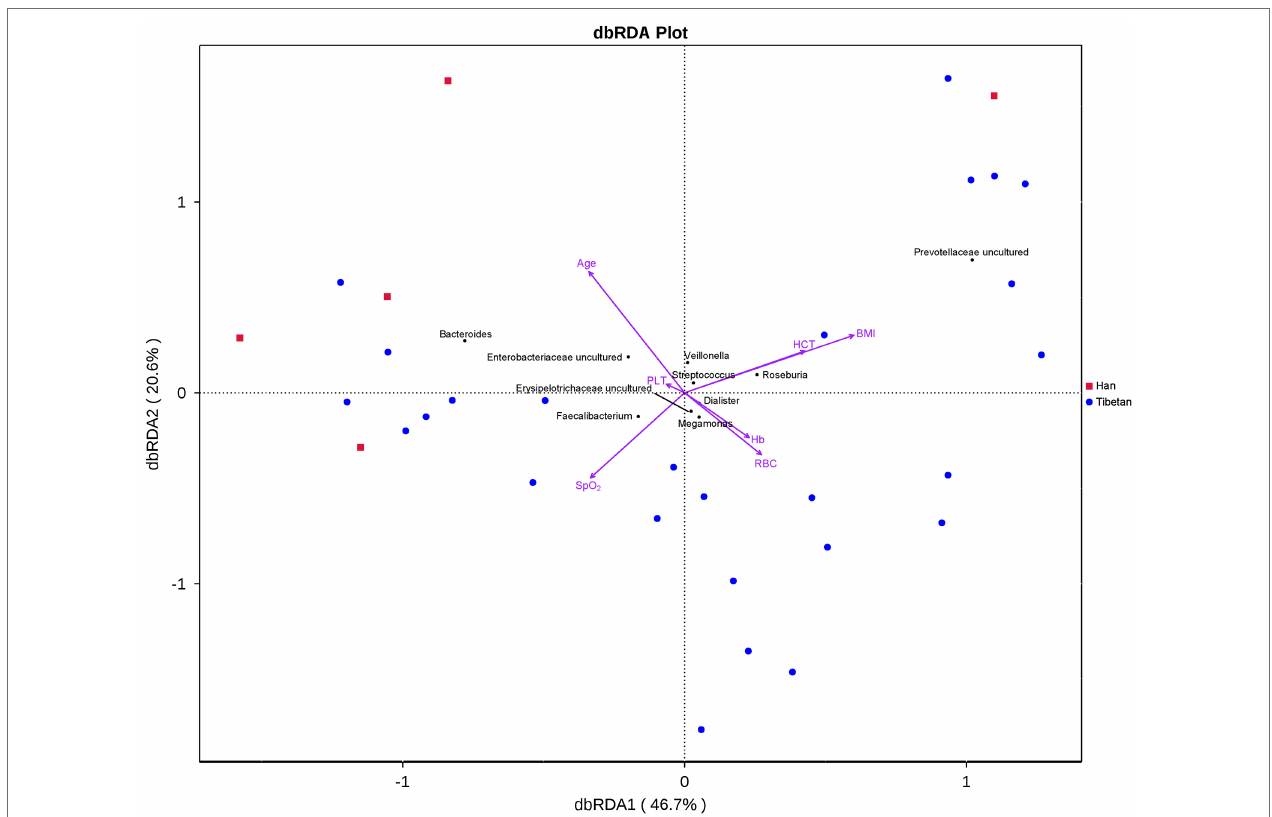
FIGURE 5 | Bray–Curtis distance-based redundancy analysis (dbRDA) of the fecal microbiota and explanatory variables in native Tibetans and Han immigrants.